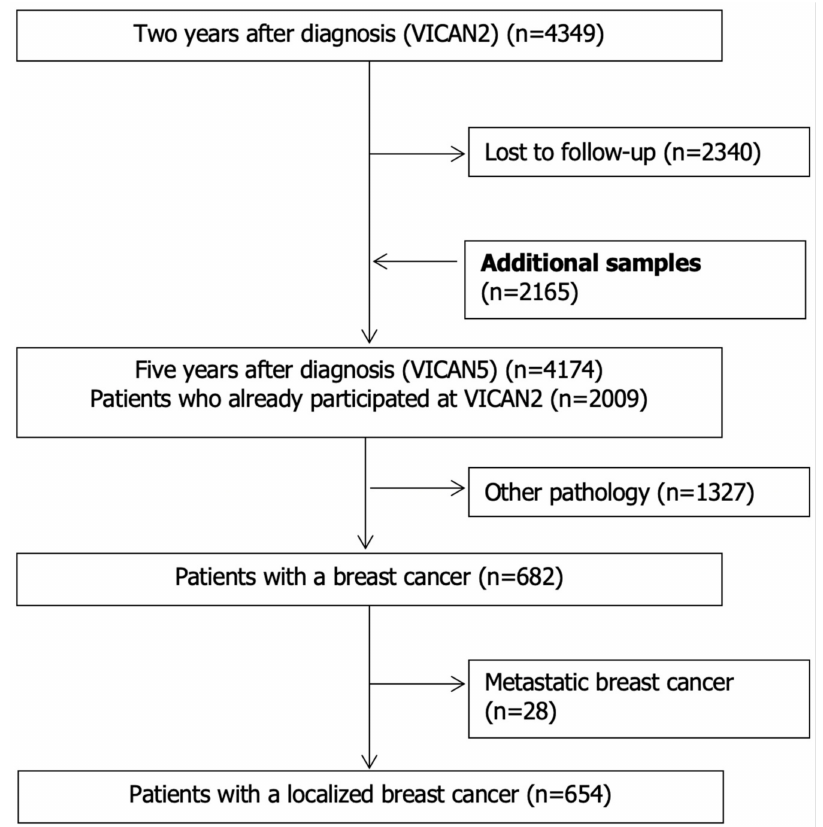
Figure 1. Flow chart of the study population, “vie apr è s cancer” (VICAN) ( n =